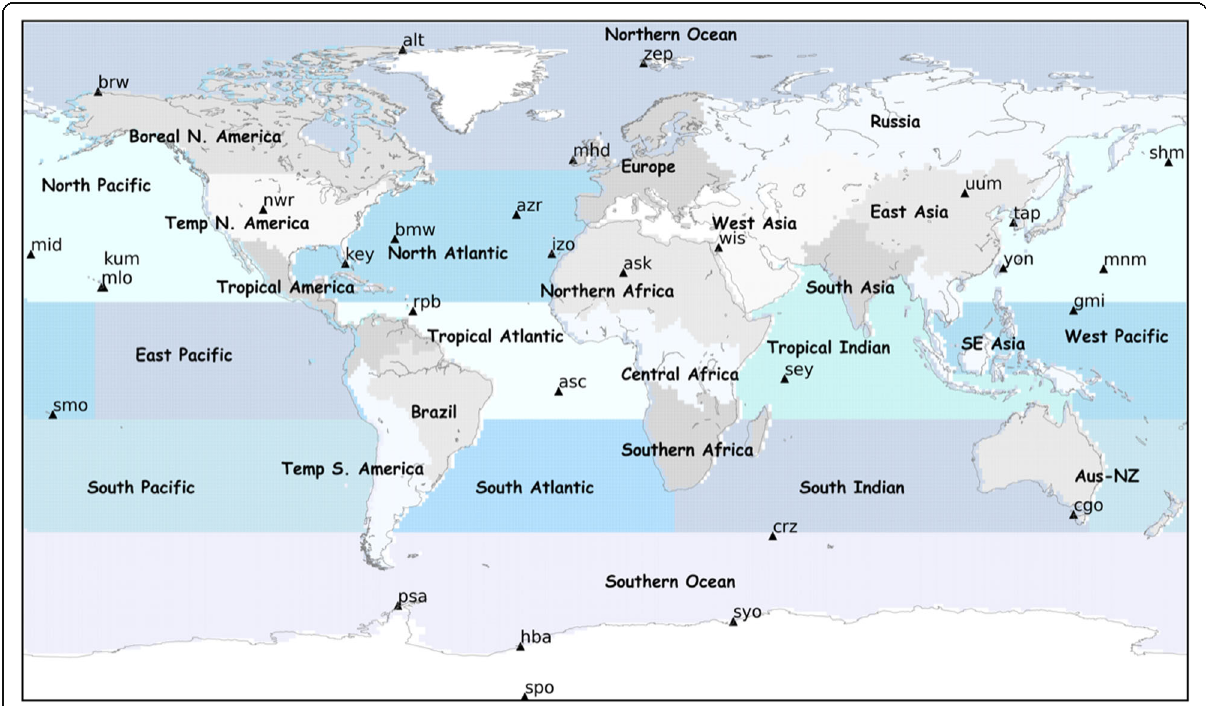
Fig. 1 Regional divisions of land (15) and ocean (11), along with their names, for time series analysis shown by the map. The in situ measurement sites used in the MIROC4-ACTM inversion are shown by triangles and marked by their 3-letter site abbreviation, as per the World Meteorological Organisation – World Data Centre for Greenhouse Gases (WMO-WDCGG). CO 2 data for 28 sites are taken from NOAA (https:// www.esrl.noaa.gov/gmd/ccgg/flask.php), and data for YON and MNM are taken from JMA